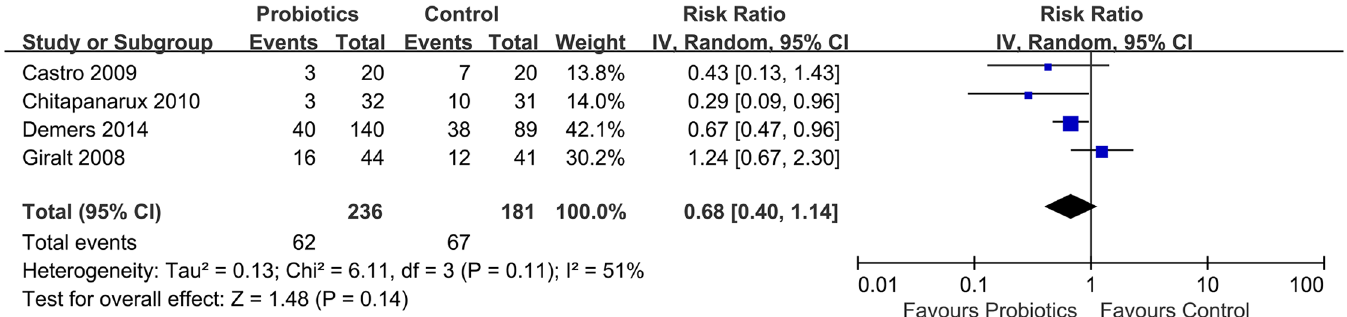
PLOS ONE | https://doi.org/10.1371/journal.pone.0178870 June 2,